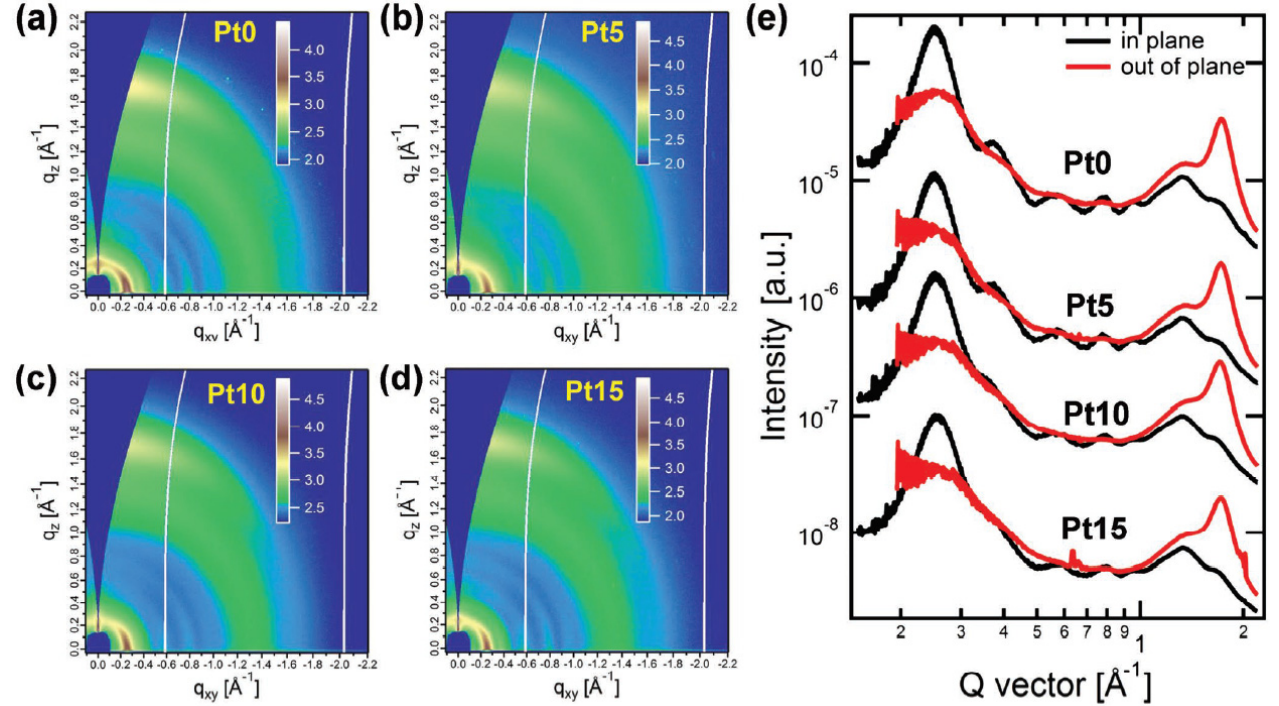
Figure 6. ( a – d ) The 2D-GIWXAS patterns. ( e ) IP and OOP line-cut profiles. Reproduced from [63]. Reprinted with permission from ref. [63]. Copyright 2019 Wiley.